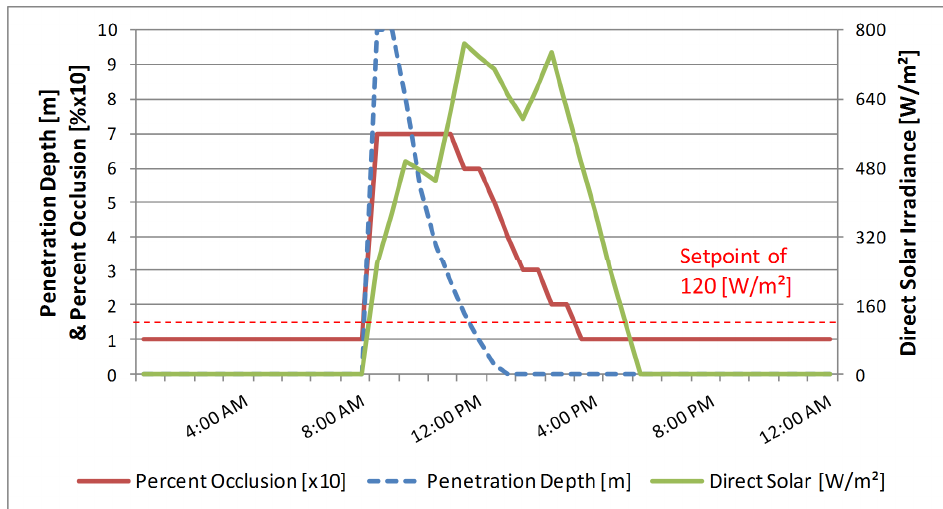
Figure 7. Hourly algorithm response for east façade first floor on 5 December (Blindswitch A).